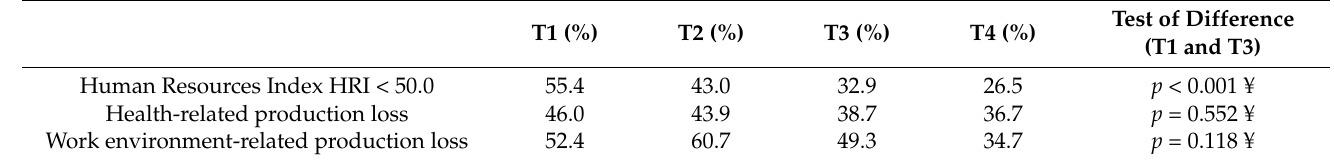
Table 2. Proportion of HRI < 50.0 and proportion of respondents reporting production